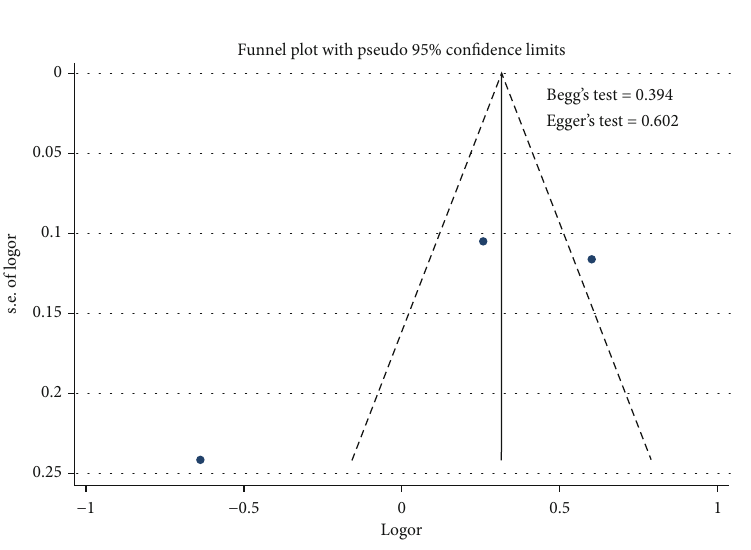
Figure 5: Funnel plots role of use of antihypertensive drugs on the uncontrolled